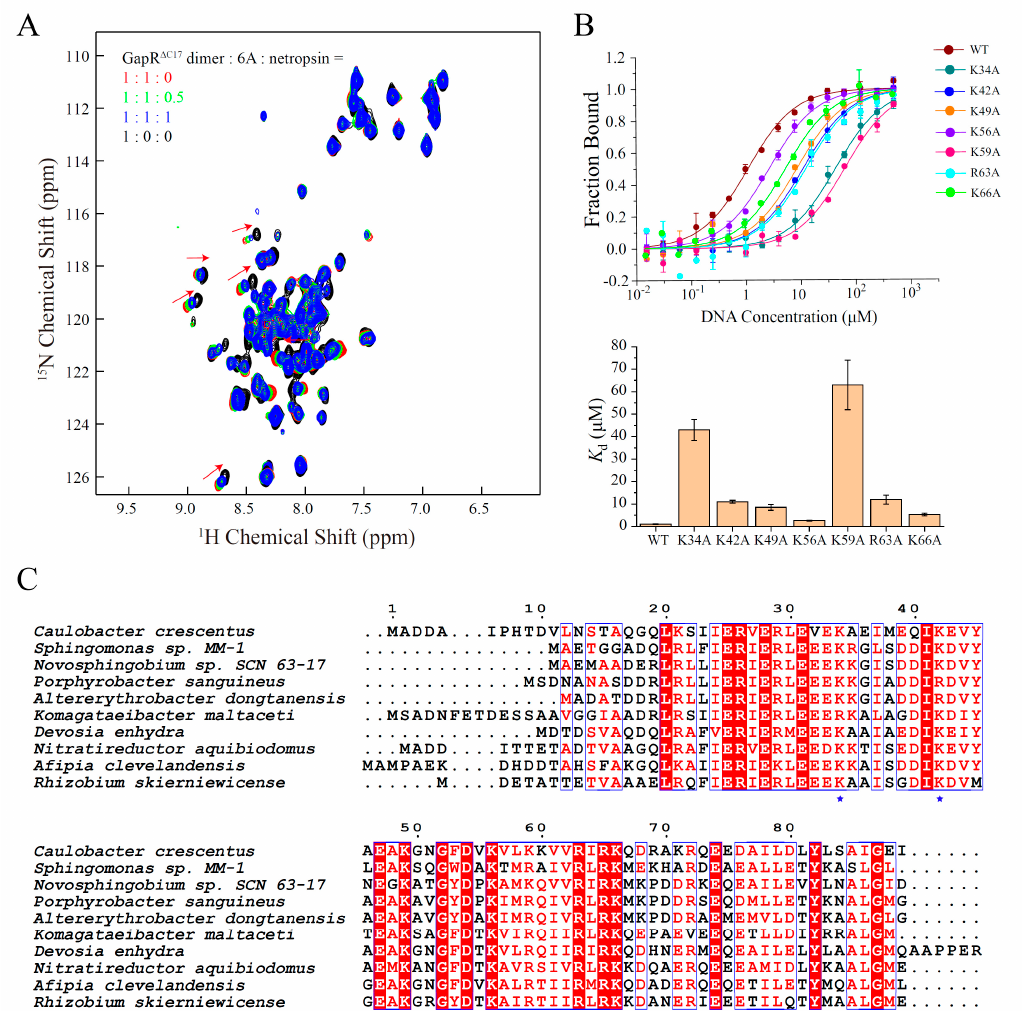
Figure 4. Validations of the structure model of GapR Δ C17 /6A DNA. ( A ) 2D 1 H- 15 N HSQC of GapR Δ C17 with different ratios of 6A DNA and a DNA minor groove binding molecule netropsin. ( B ) DNA binding affinities of WT and mutant GapR Δ C17 proteins with 6A DNA, measured by microscale thermophoresis experiments. The error bars were calculated from three independent measures. ( C ) Sequence alignment of GapR homologs from different species. The lysine/arginine residues involved in DNA binding are marked with blue stars.